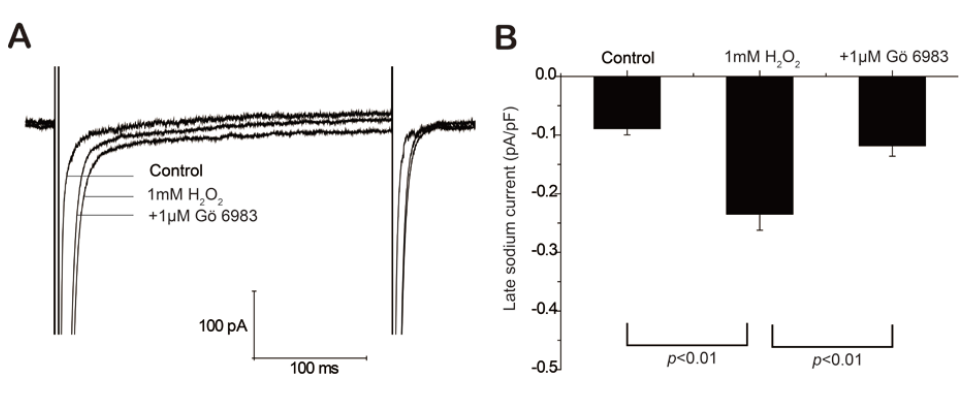
Figure 5. Effects of Gö 6983 on H 2 O 2 -induced late sodium current (I Na,L ) elevation. Representative current-voltage traces ( A ) and summary data of I Na,L at − 30 mV under control condition, in the presence of 1 mM H 2 O 2 alone or plus 1 µ M Gö 6983 ( B ) are shown.